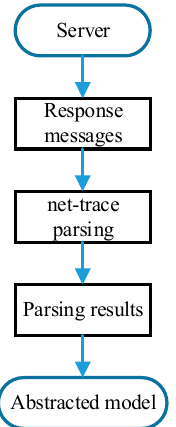
Figure 18. Generation of the server model.